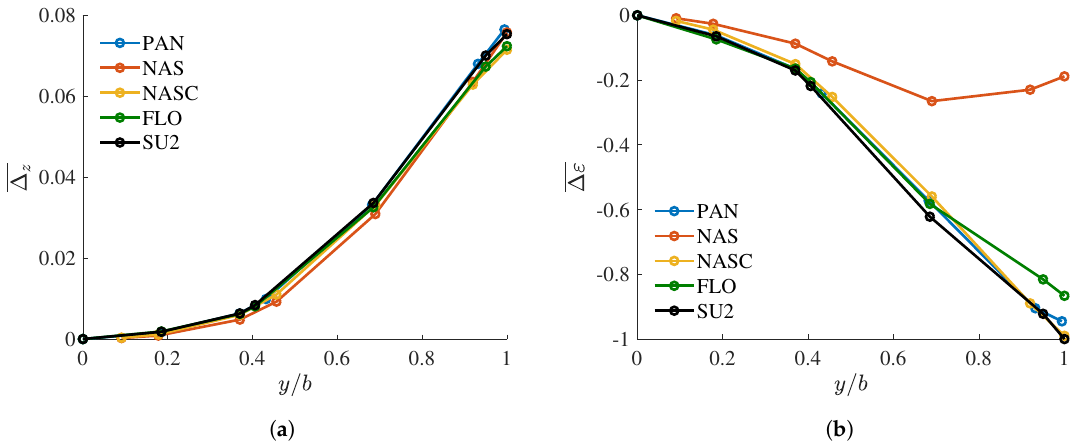
Figure 8. Static deflection along the span of the Embraer wing at Mach 0.78 and lift coefficient 0.60, obtained from different levels of fidelity: ( a ) mean vertical displacement; and ( b ) nose-up